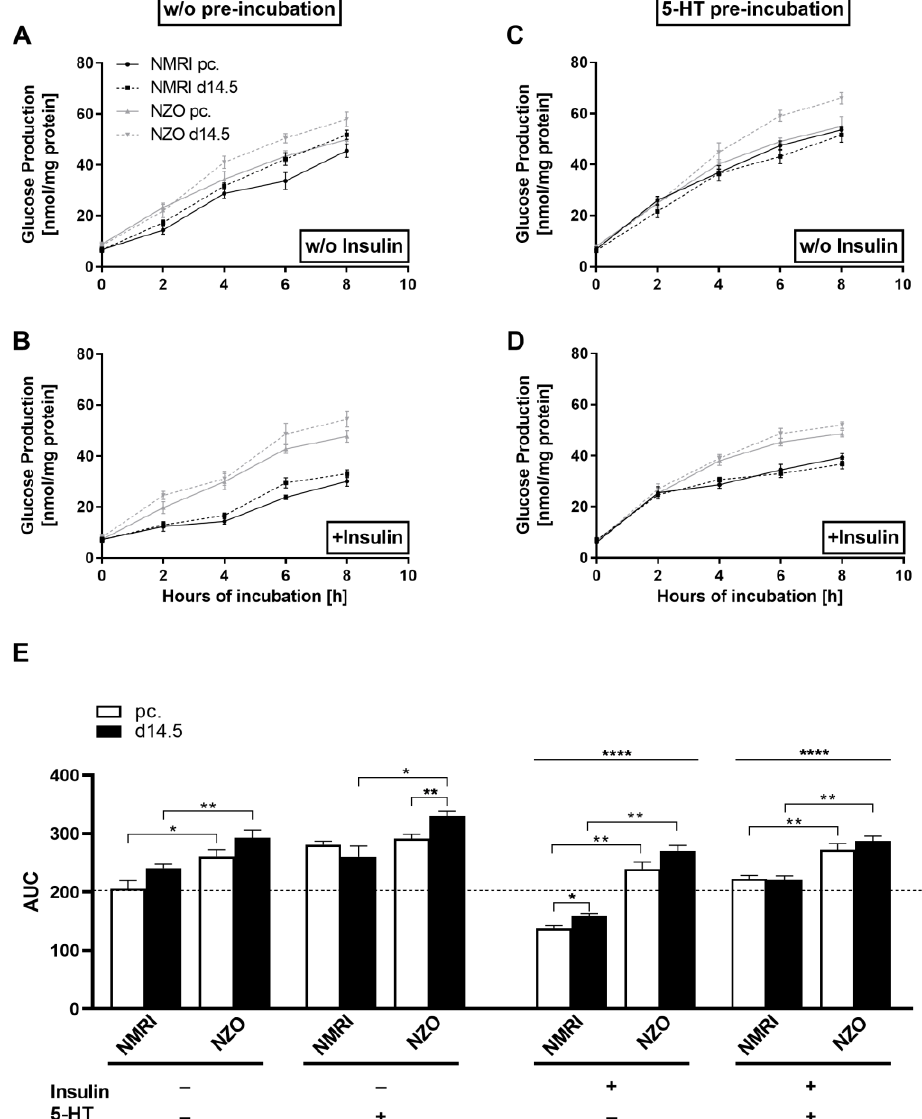
Figure 5. Altered glucose utilization in primary NZO hepatocytes. Glucose production in cultured primary hepatocytes of female NZO and NMRI control mice at time points preconceptional and d14.5 of gestation. Preincubation without ( w / o ) ( A , B ) or with 5-HT ( C , D ) and stimulation w / o ( A , C ) or with insulin ( B , D ). Area under the curve (AUC) for glucose production using the trapezoidal rule at time points preconceptional (white bars) and d14.5 (black bars) ( E ). Data are presented as means ± SEM ( n = 5 animals per group). * p < 0.05, ** p < 0.01, multiple comparison tests results between groups: w / o I vs. +I: **** p < 0.0001, +I vs. +I+5-HT: **** p < 0.0001.